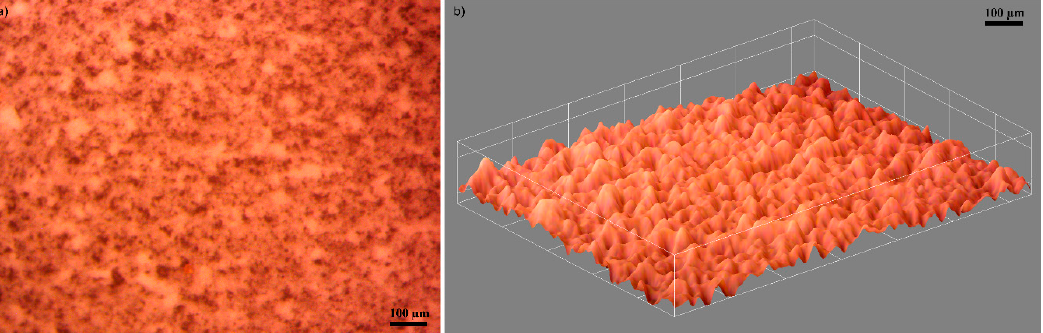
Figure 7. Metallographic microcopy image (10× magnification) of the AgZnHApCs coating’s surface ( a ) and 3D representation of the surface of the AgZnHApCs coating ( b ).